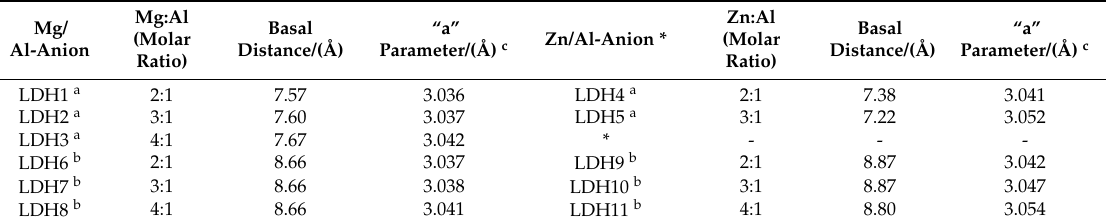
Table 2. Nomenclature used for the prepared LDH solids with different intercalated anions, basal distance (obtained by XRPD experiments) and calculated “a” parameter.